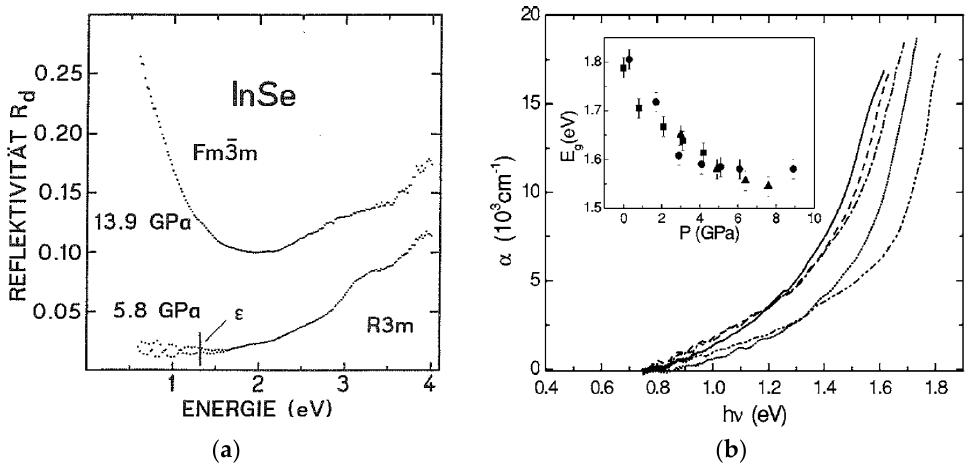
Figure 15. ( a ) Reflectivity versus photon energy in the plasma spectral range of RS-InSe [27]. ( b ) Absorption edge of monoclinic InSe under high pressure. Inset: pressure dependence of the direct bandgap in MC InSe [41].